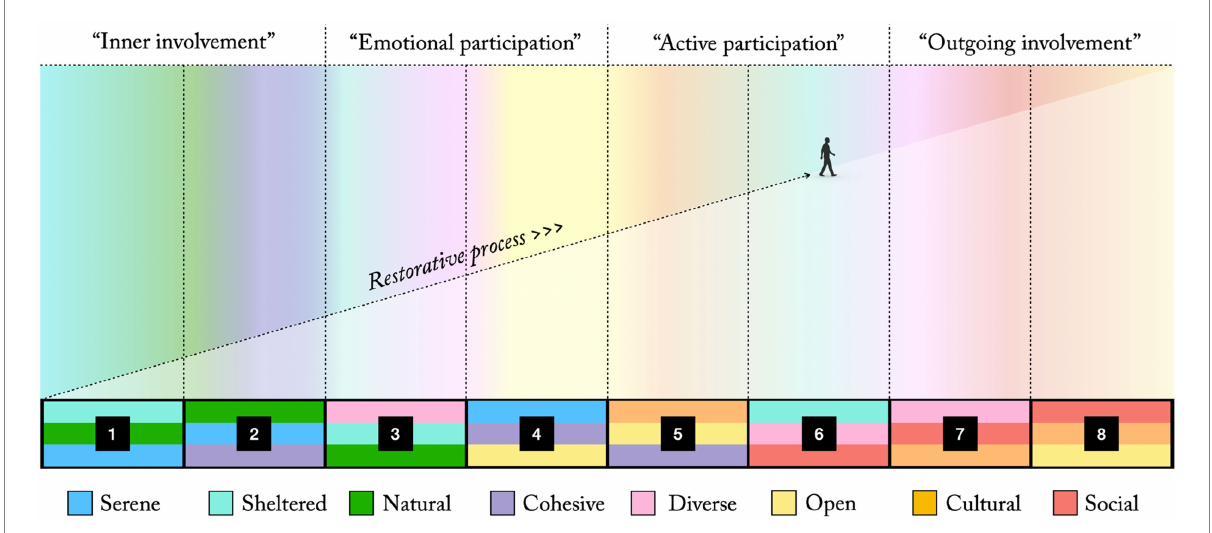
FIGURE A2 A sensory opportunity spectrum (SOS) with eight PSD combinations (Cluster 1–8) supporting different stages of restoration, roughly mapped unto four phases of the restorative process suggested by Grahn et al.